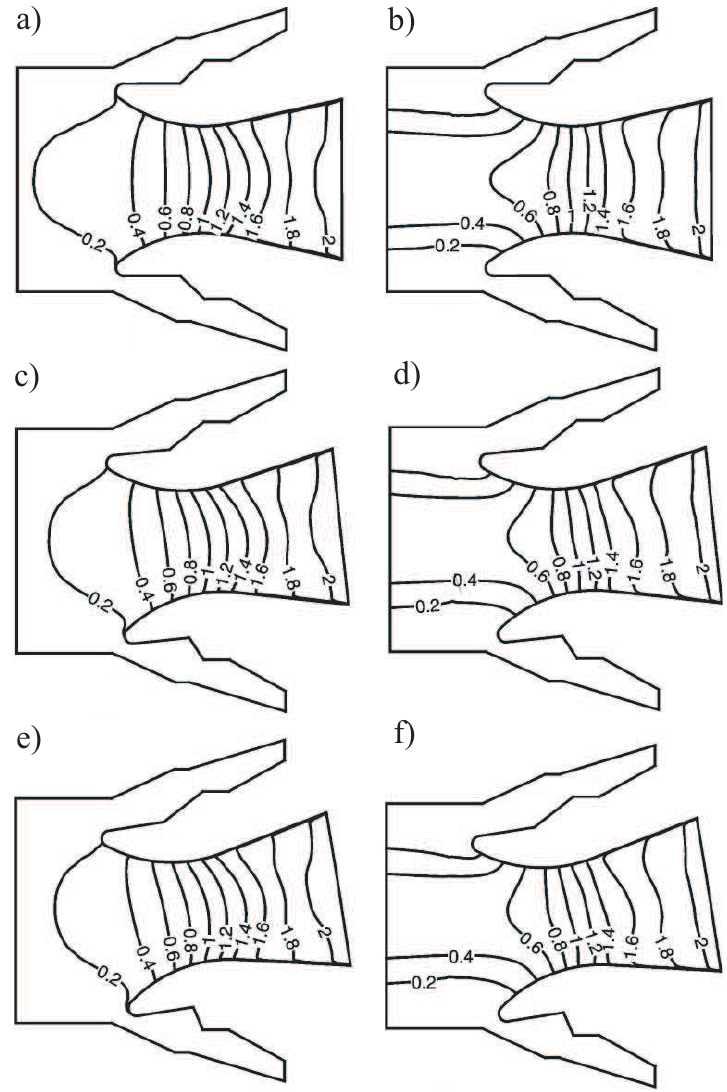
Figure 12. Contours of Mach number in nozzle sweeping plane for α = 0 ◦ ( a , b ), 6 ◦ ( c , d ), 9 ◦ ( e , f ). The sound lines in the throat section of the nozzle has a different shape for cylindrical and star-shaped propellant channels. When the combustion products outflow from the cylindrical channel in the throat of the nozzle, the classical shape of the sonic line is formed, which is an arc of a circle (Figure 12a). In the case of a star-shaped channel, the Mach number contours in the critical section have a form close to a straight line (Figure 12b). In the supersonic part of the nozzle, the shape of the Mach contours is distorted, which is associated with both the influence of boundary conditions and the presence of nozzle shock waves. Figure 13. Section a corresponds to the swinging plane of the nozzle without turning it, and section b corresponds to the sweeping plane of the nozzle with its rotation at a given angle. Sections c–f correspond to planes located at angles of 30 ◦ , 345 ◦ , 60 ◦ , and 90 ◦ to the nozzle sweeping